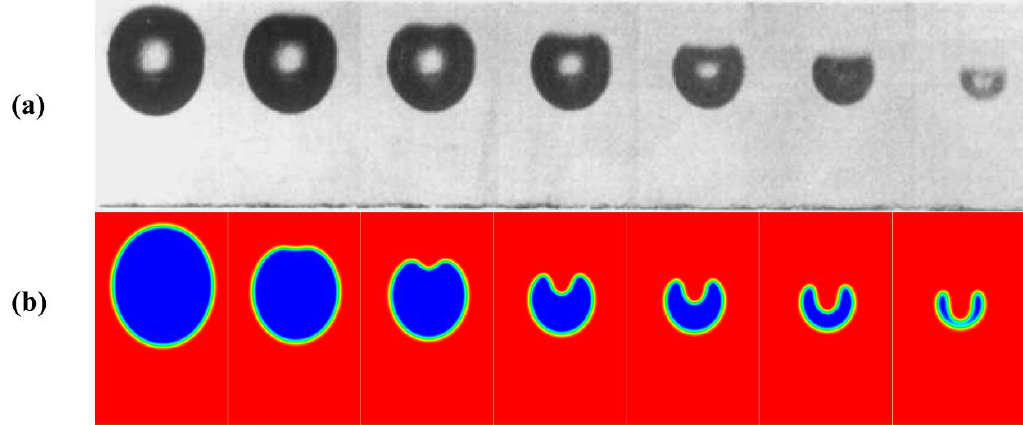
Figure 2. Comparison of the results between experimental image and simulation by LBM-MRT. ( a ) Experimental images [31], ( b ) simulation results.